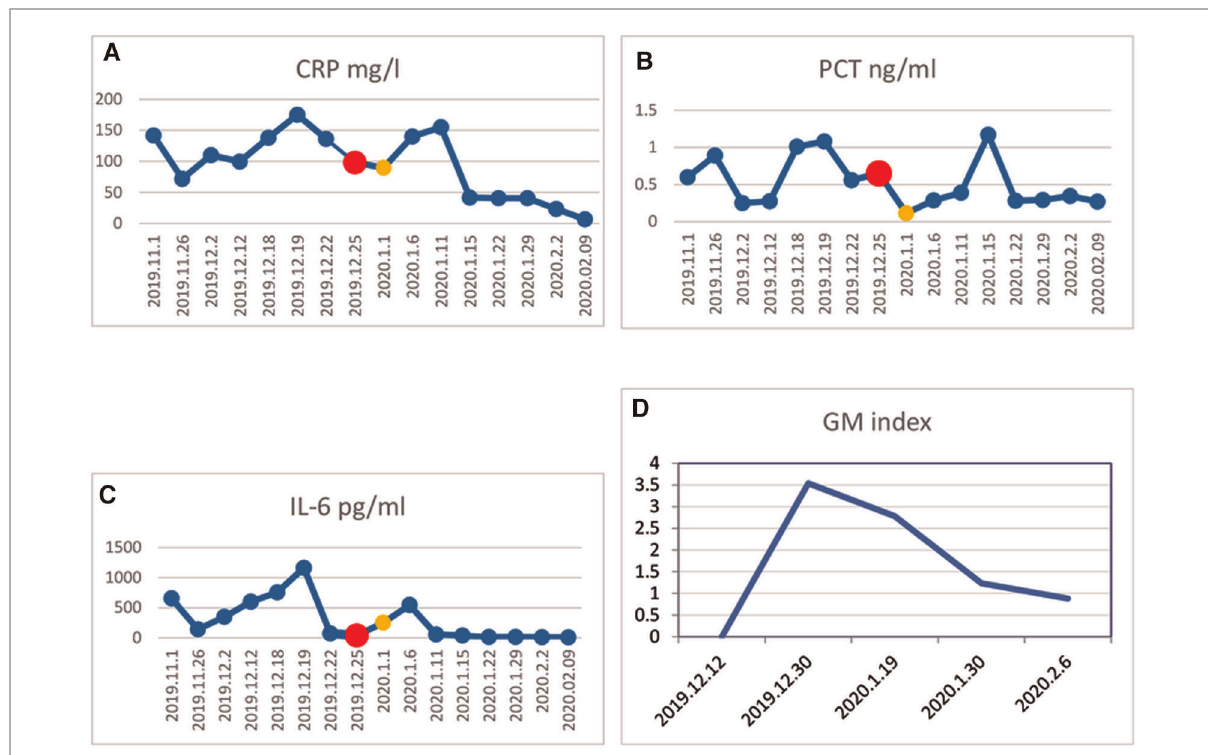
FIGURE 3 Change in in fl ammatory factor levels in CRP ( A ), PCT ( B ), IL-6 ( C ), and GM ( D ). The red dot in the line represents the beginning of preconditioning on Dec. 25, 2019, and the yellow dot represents the day of HSCT on Jan. 1, 2020. The patient received HSCT when in fl ammatory factors levels reduced